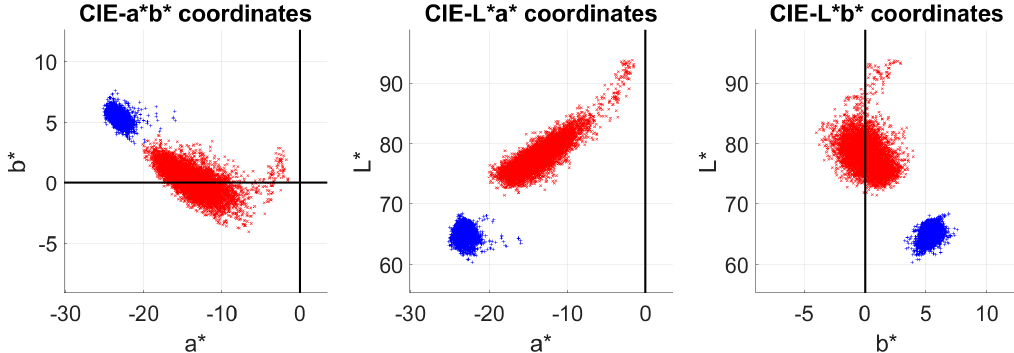
Figure 6. 2D projections of the L* , a* , b* color space plotting pixel-wise color information of sample 1 in probe 1, before (blue) and after (red) cleaning.